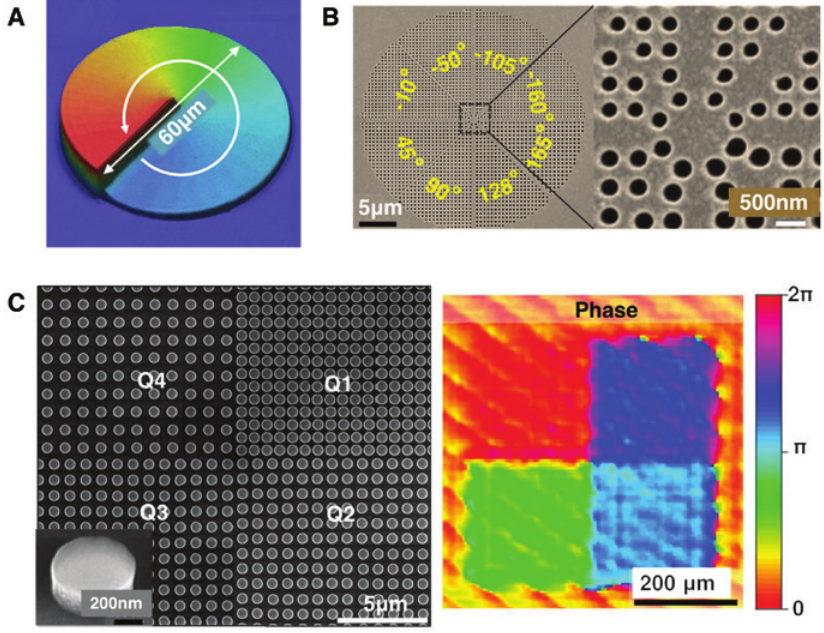
Figure 1: Optical vortex beam generated by dynamic phase plates. (A) Optical profilometry image of a 60- μ m diameter 3D femtosecond laser printed mirco-SPP with continuous phase changing generates optical vortex with topological charge ℓ = 5 at 633 nm. Reprinted from Ref. [86]. (B) Nanowaveguide array with a phase modulation